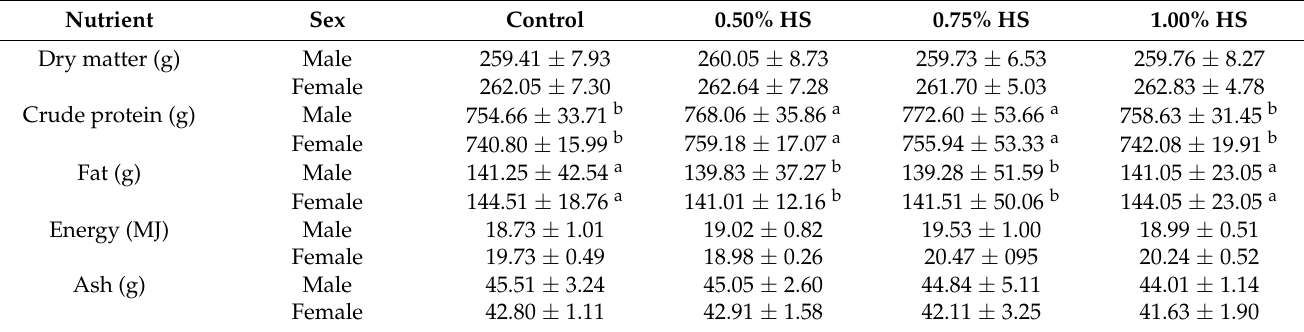
Table 5. The effect of HSs on the content of nutrients in thigh samples.